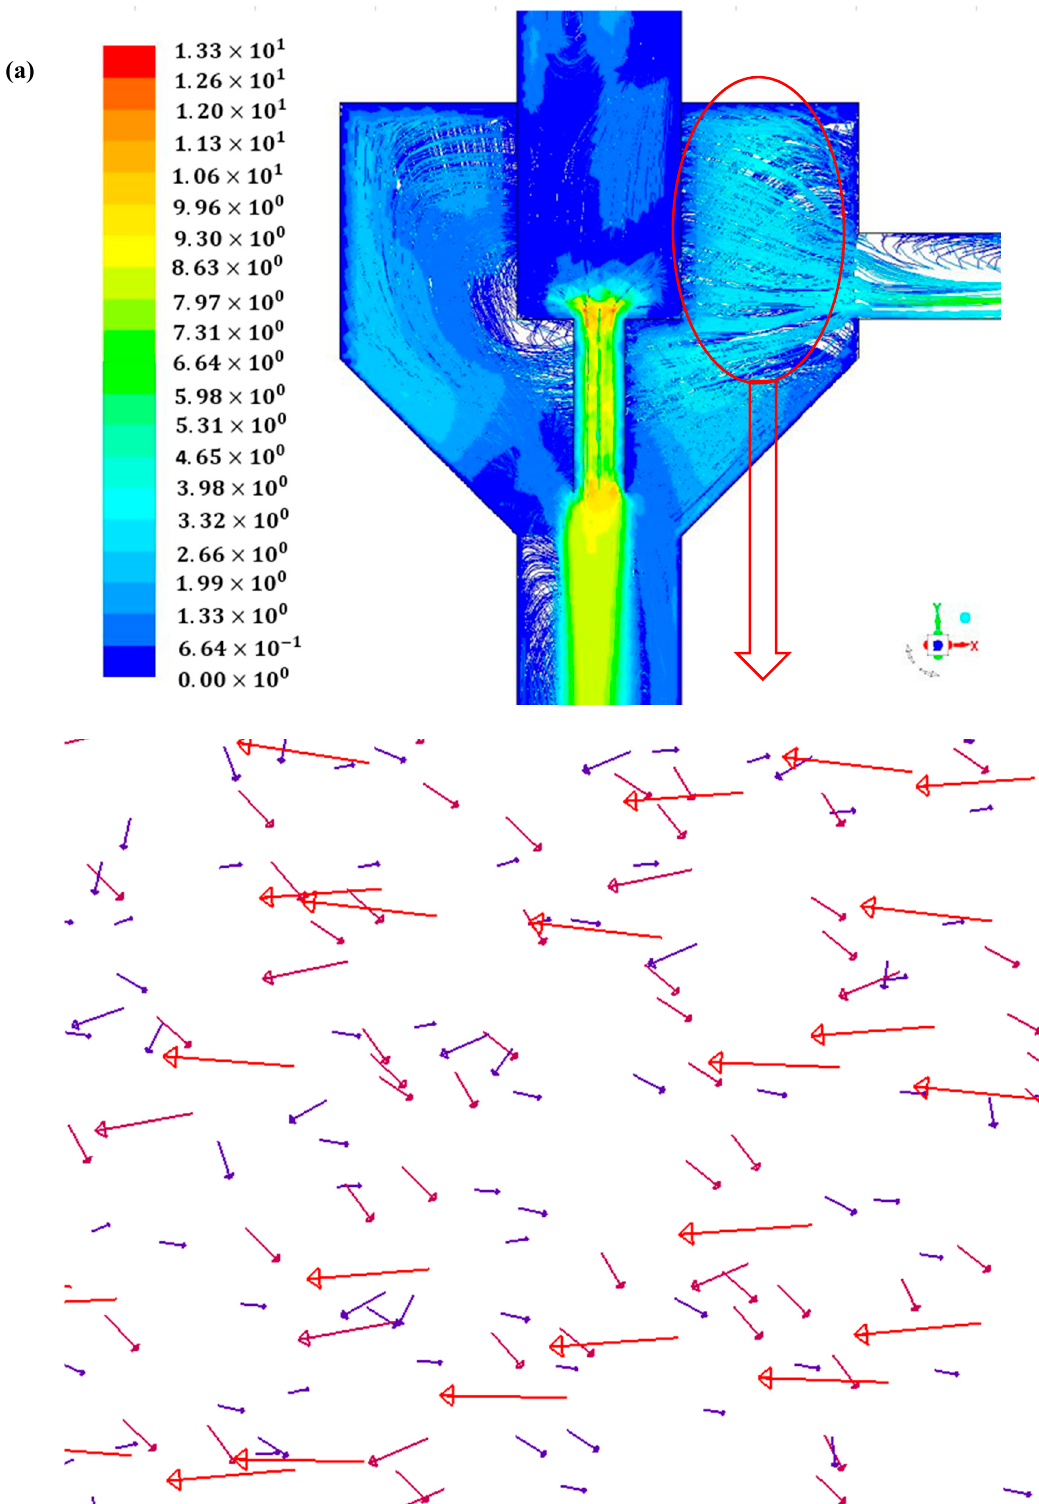
Figure 7. ( a ) The pathlines of air velocity [m/s], ( b ) the vector of air velocity.